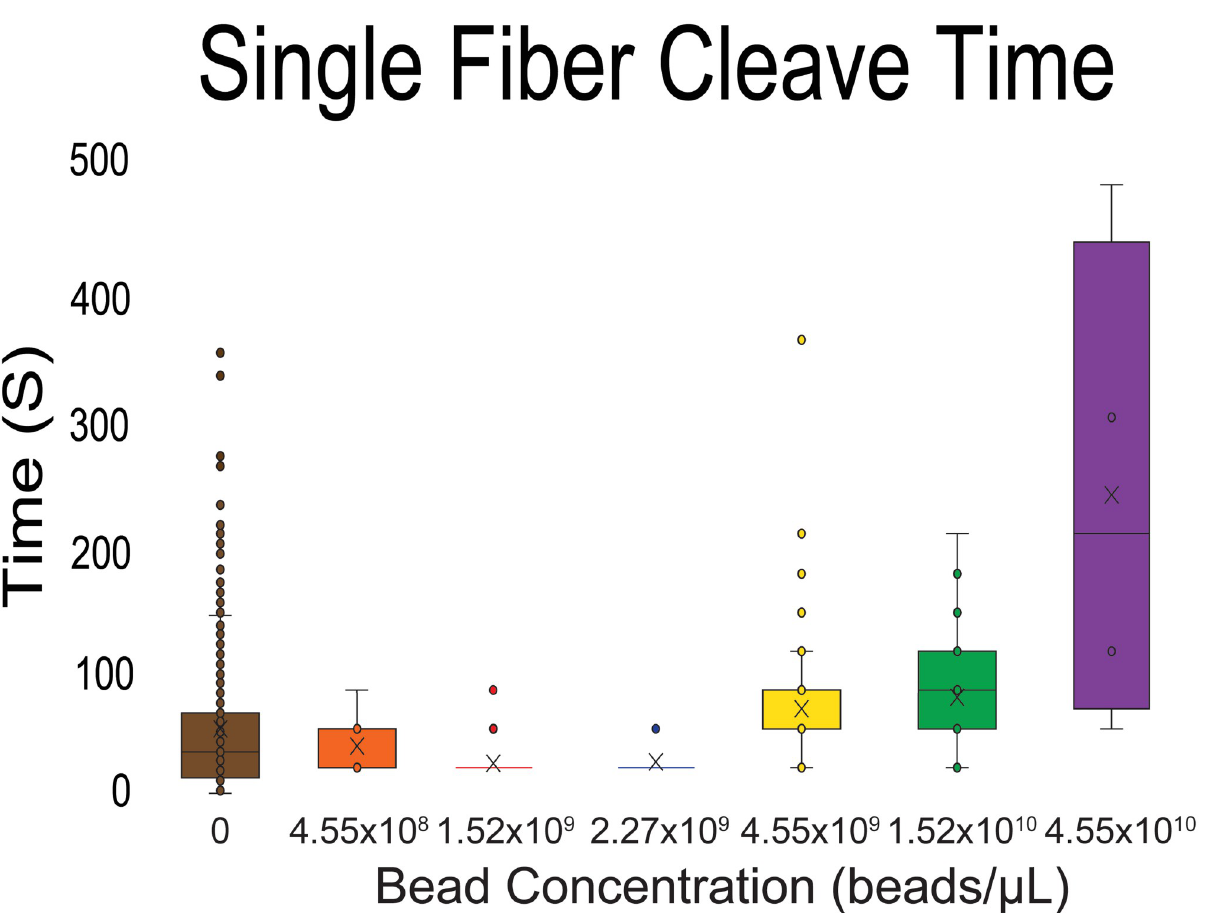
Fig 6. Box and whisker plots of cleavage time as a function of bead concentration: Cleavage time was calculated as the time between the addition of plasmin and the first image in the time series where cleavage was observed. This frame number was multiplied by the frame interval (30 s) and 30 s were subtracted to adjust for first image in the time-lapse (captured at the time of plasmin addition). The number of fibers used to calculate the mean cleavage time at each concentration is as follows: Nfiber = 5 (4.55x10 10 beads/ μ L), 31 (1.52x10 10 beads/ μ L), 49 (4.55x10 9 beads/ μ L), 70 (2.27x10 9 beads/ μ L), and 85 (1.52x10 9 beads/ μ L). The calculated mean cleavage times (represented as an X on the box and whisker plot) are as follows: 4.55x10 10 beads/ μ L = 240 ± 85 s, 1.52x10 10 beads/ μ L = 84 ± 20 s, 4.55x10 9 beads/ μ L = 75 ± 23 s, 2.27x10 9 beads/ μ L = 35 ± 5 s, and 1.52x10 9 beads/ μ L = 34 ± 5 s. The “box” represents the first and third quartile (the interquartile range) of fiber cleavage times for each data set, and where applicable, the horizontal line inside the box signifies the median of the data set. The “whiskers” represent values 1.5x above and below the interquartile range of cleavage times of each data set and are as follows: 4.55x10 9 beads/ μ L = 30 s and 120 s, 1.52x10 10 beads/ μ L = 30 s and 210 s, and 4.55x10 10 beads/ μ L = 60 s and 480 s. Where applicable, cleavage times falling outside the whiskers are represented as